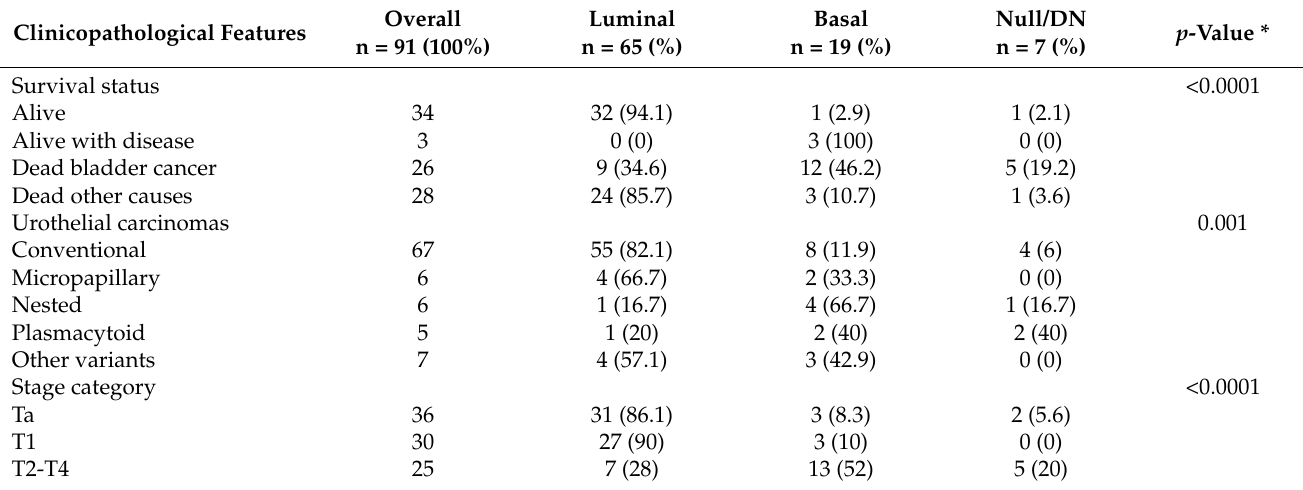
Figure 3. NanoString gene expression generated molecular classification of bladder cancer. The heatmap shows the luminal (GATA3+ and/or KRT20+), basal (KRT14+/KRT5+/GATA3low/-/KRT20low/-), and null (GATA3 − , KRT20 − , KRT5 − , KRT14-) subtypes ( A ). Box and whisker plots of the normalized values (mean ± SD), illustrate the expression of GATA3, KRT20, KRT5, and KRT14 ( B ). The Kaplan – Meier plots identify meaningful molecular subtypes for CSS with luminal subtype as the less aggressive and basal/null-double negative subtypes being the more aggressive end of the spectrum ( C ). A subsequent substudy of “C” excluding stage Ta tumors is presented in ( D ). Molecular subtypes also expressed differences according to pathologic tumor classification (conventional vs. variant histology urothelial carcinoma) ( E ). Table 2. Relationship between molecular subtypes and clinicopathological parameters of 91 bladder carcinomas included in the